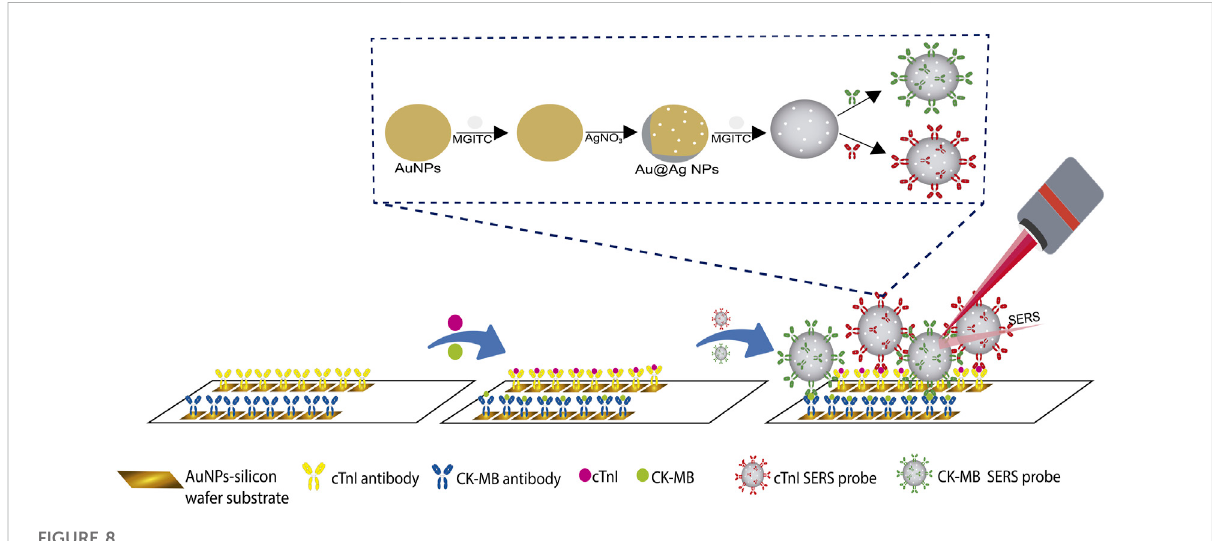
FIGURE 8 Schematic representation of SERS-based sandwich immunoassay for the independent quanti fi cation of cTnI and CK-MB, adapted from Cheng et al.